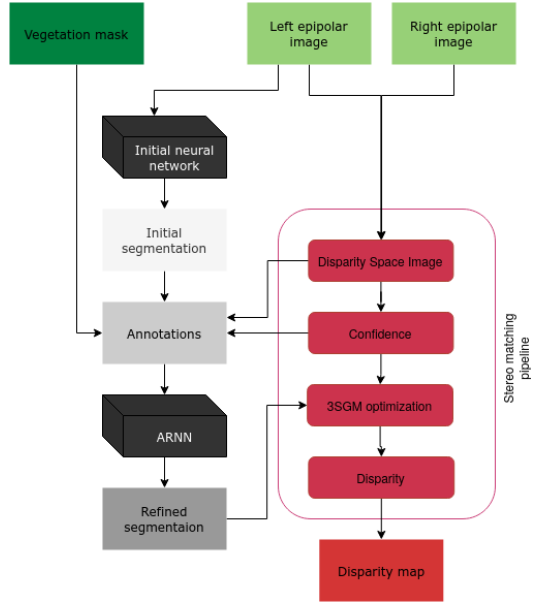
Figure 1. Our stereo pipeline: 3SGM optimization with labels from an Automatically Refined Neural Network (ARNN).